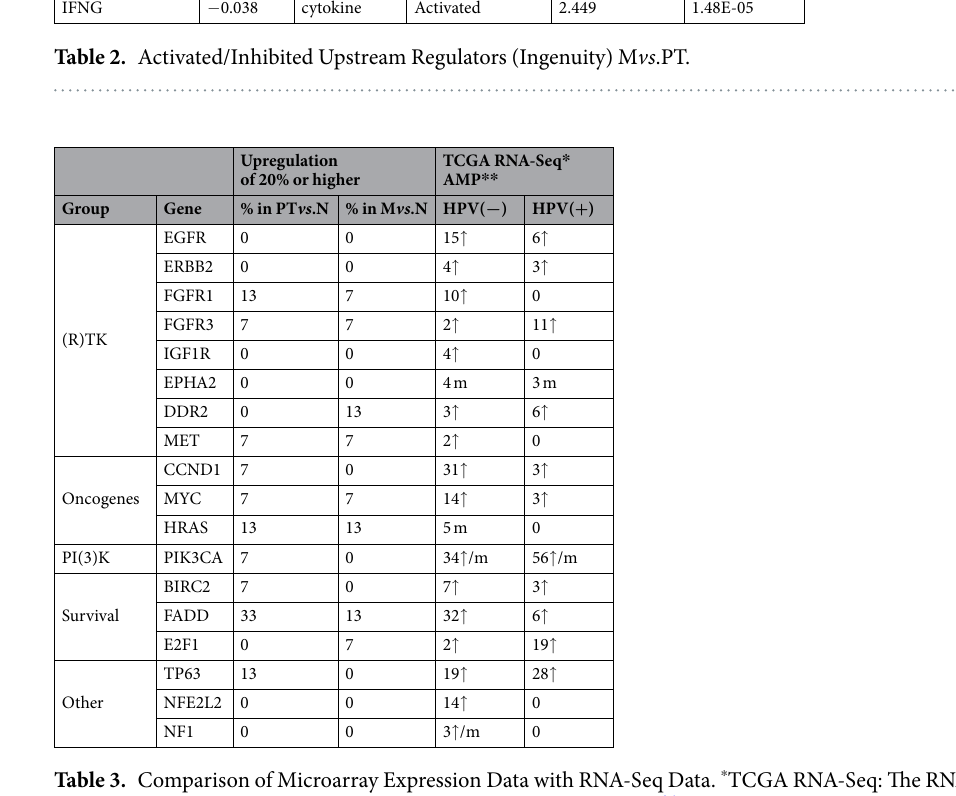
Table 3. Comparison of Microarray Expression Data with RNA-Seq Data. * TCGA RNA-Seq: The RNA sequencing data as published by The Cancer Genome Atlas Network 36 ; the Broad Institute TCGA Genome Data The Cancer Genome Atlas Network 36 . ↑ predicted as amplified; ↑ /m predicted as amplified or